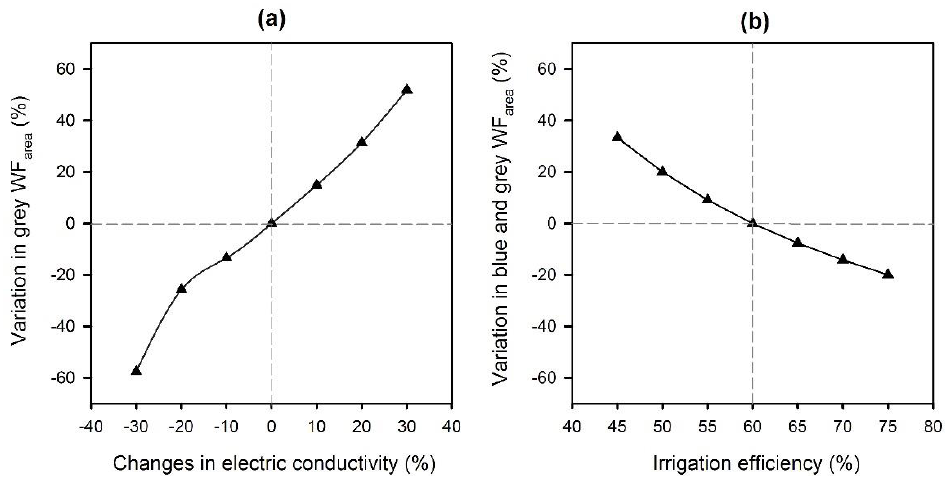
Figure 4. Sensitivity analysis of ( a ) electric conductivity and ( b ) irrigation efficiency and their effects on the grey and blue regional water footprints.